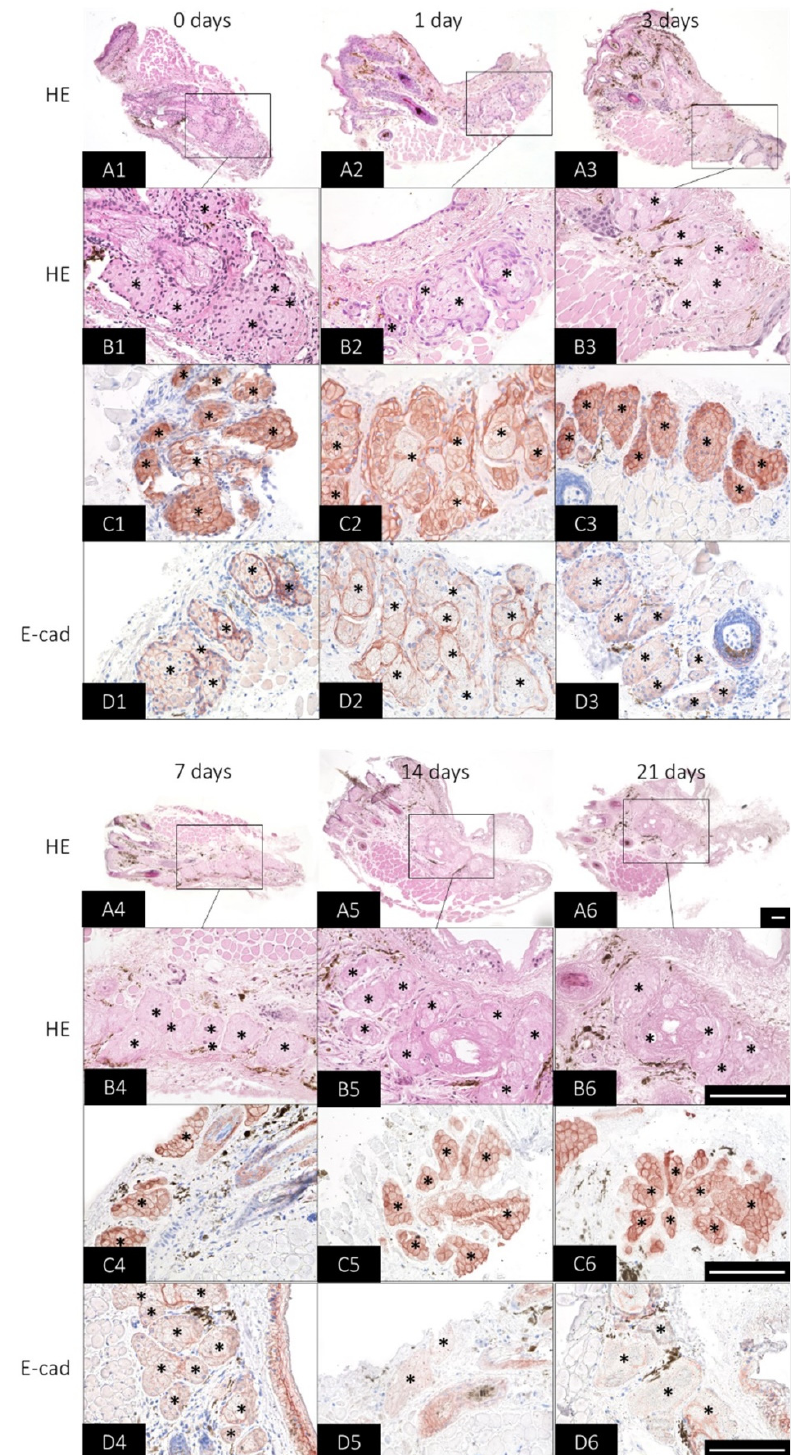
Figure 3. Histological changes of organotypic slice cultures (OSC) of mouse meibomian glands (mMG) over 21 days. Representative pictures of mMG OSC morphology visualized by hematoxylin and eosin (HE), cytokeratin 14 (CK14) and E-cadherin (E-cad)-staining for 21 days. HE at 100× magnification serves as an overview staining for the OSC ( A1 – A6 ). The 400× magnification shows that as the cultivation time progresses, fewer nuclei can be stained in the mMG acini (*) ( B1 – B6 ). CK14 antibody reaction is maintained in the meibomian gland acini (*) over the culture period ( C1 – C6 ), whereas E-cad immunoreaction decreases at 14 and 21 days ( D1 – D6 ). Data are n = 3, scale bar = 100 µm ( A1 – D6 ).